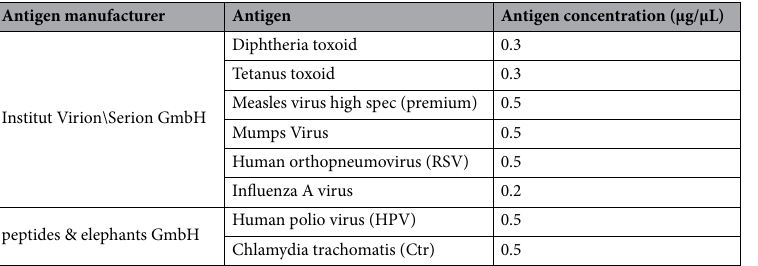
Table 3. Vaccine antigens and peptides spotted on the microarray